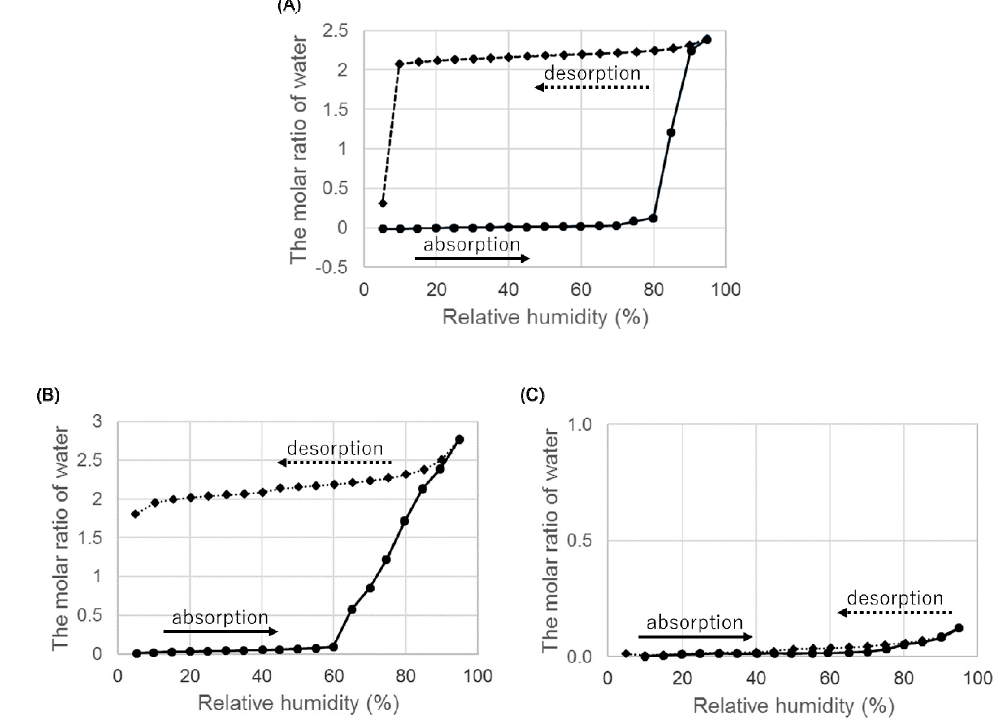
Figure 7. Hygroscopicity of ondansetron salts anhydrates at 25 °C. ( A ) Hydrobromide anhydrate B, ( B ) hydroiodide anhydrate A, and ( C ) hydroiodide anhydrate B.